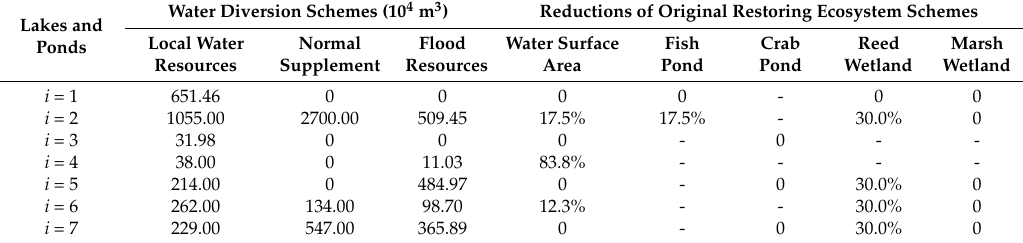
Table 6. Water diversion schemes and reductions with respect to the original ecosystem restoration schemes of lakes and ponds in western Jilin Province (Nong’an County in the Songhua River basin, for